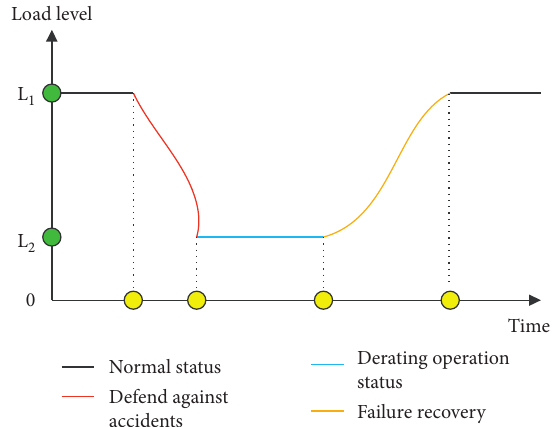
Figure 2: Schematic diagram of the system function curve of the smart grid under extreme